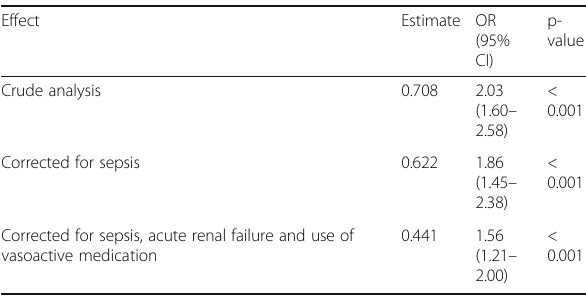
Table 1 (abstract 001338). Association between early hyperbilirubinemia and 30-day-mortality in patients with a low platelet count (< 150 x 109/l) (N = 1780)